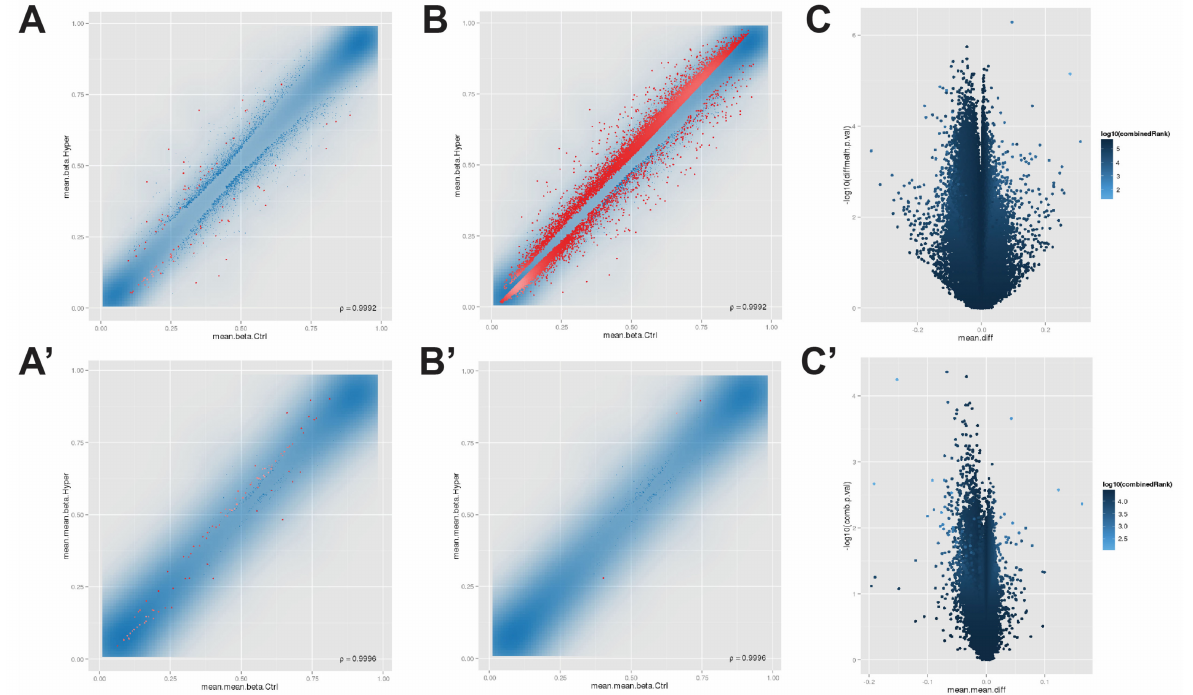
Figure 1. The detected DMPs or DMRs of control vs. hypersensitivity reactions. ( A ) Top 100 DMPs. The x- and y -axis are the mean β values of the control group against the hypersensitivity reactions group. The red points represent the top 100 DMPs. ( B ) DMPs with a rank higher than the threshold. The x- and y -axis have the same meaning as ( A ). The red points represent DMPs higher than the threshold. ( C ) The volcano plot of whole-genome CpG sites. The x- and y -axis denotes the mean differential β values and negative logarithm transformed p -value, respectively. The asymmetrical distribution of ( C ) revealed that the detected hypermethylated and hypomethylated sites were in different regions, which indicates the high quality of the methylation array. ( A’ ) Top 100 DMRs in promoter regions. The x- and y -axis are the mean β values of the control group against the hypersensitivity reactions. The red points represent the top 100 DMRs. ( B’ ) Promotor region DMRs with a rank higher than the threshold. The x- and y-axis have the same meaning as ( A’ ). The red points represent DMRs higher than the threshold. ( C’ ) The volcano plot of whole-genome promoter regions. The x- and y -axis denotes the mean differential β values and negative logarithm transformed p -value, respectively. The asymmetrical distribution of Figure ( C’ ) revealed that the detected hypermethylated and hypomethylated sites were in different regions, which indicates the high quality of the methylation